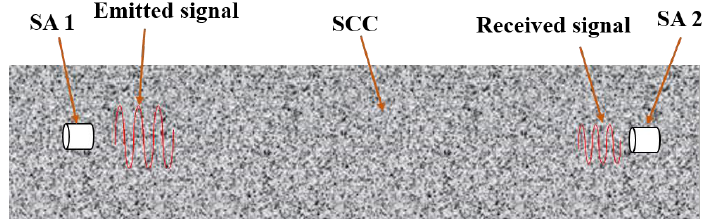
Figure 3. The schematic of smart aggregate based active sensing approach.